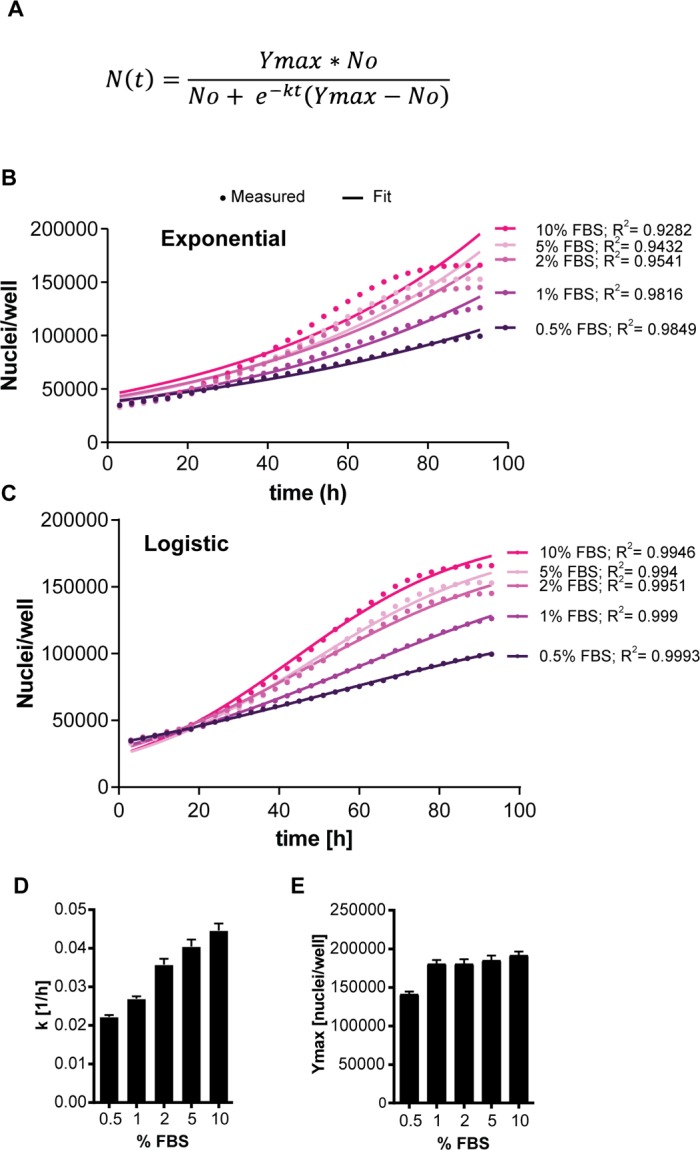
Fitting changes in cell number over time using the Logistic growth equation.(A) Logistic growth equation. K is the growth rate in 1/h which is equivalent to the exponential growth rate at low density, and Ymax is the maximum number of cells reached per condition. (B, C) Flipin-Trex-293 cells expressing nuclear mCherry were seeded in varying concentrations of fetal bovine serum (FBS). Cells were imaged on an Incycte to track changes in cell count over time. The change in the number of nuclei/well over time is reflected in the growth rate. The growth rate decreases over time and is better modelled as logistic (C) rather than exponential growth (B). While the population growth rate estimated by fitting to the logistic growth model, k, increases by increasing fetal bovine serum (FBS) (D), the carrying capacity of a culture (Ymax) does not once the FBS concentration is above 0.5% (E). (D), (E): n = 5, mean ± SEM. (C), (B): dots are the raw data points representing the average of 5 wells and lines are the fits to the corresponding model.